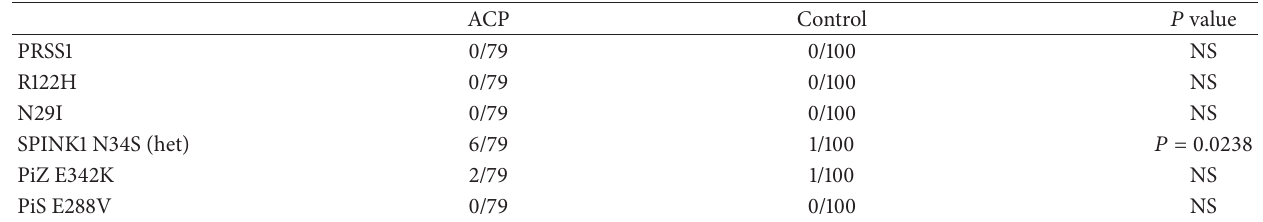
Table 3: Distribution of PRSS1, SPINK1, PiZ, and PiS in ACP patients and